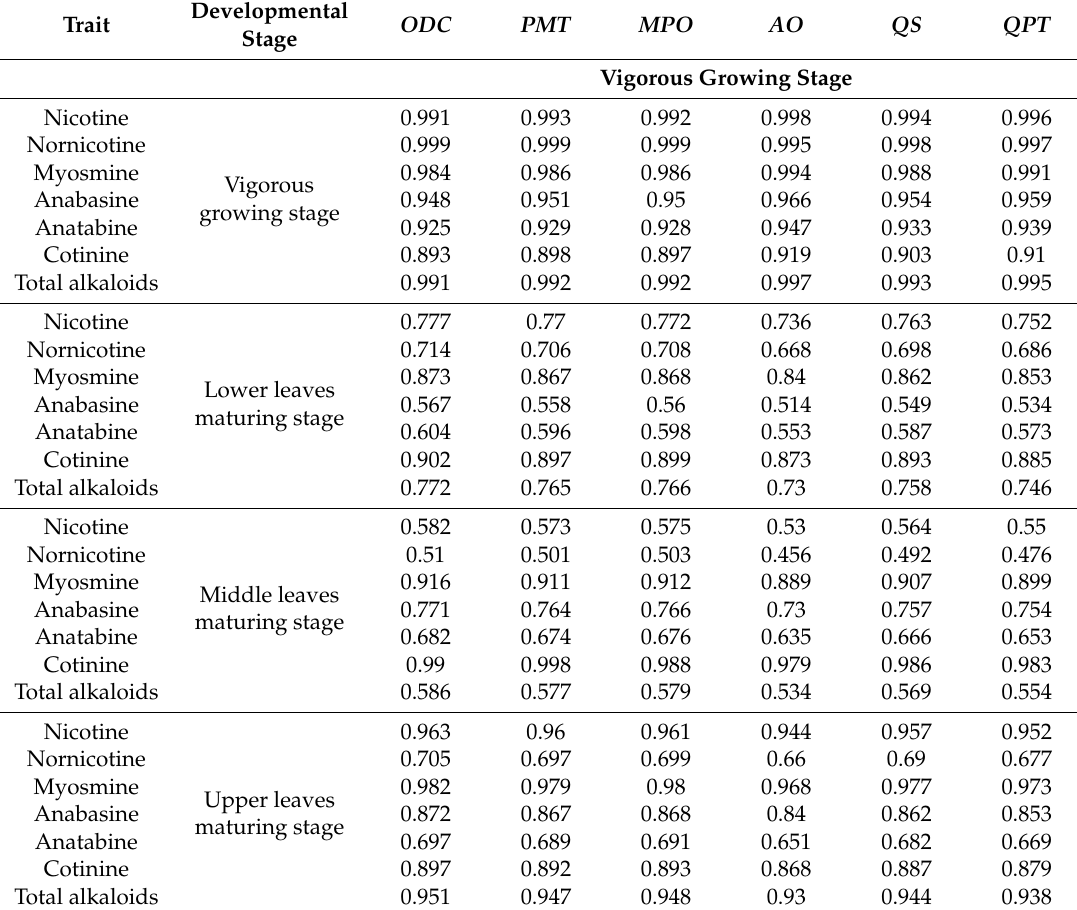
Table 4. Correlation coefficient between gene transcription levels at the vigorous growing stage and alkaloids contents in Nicotiana tabacum